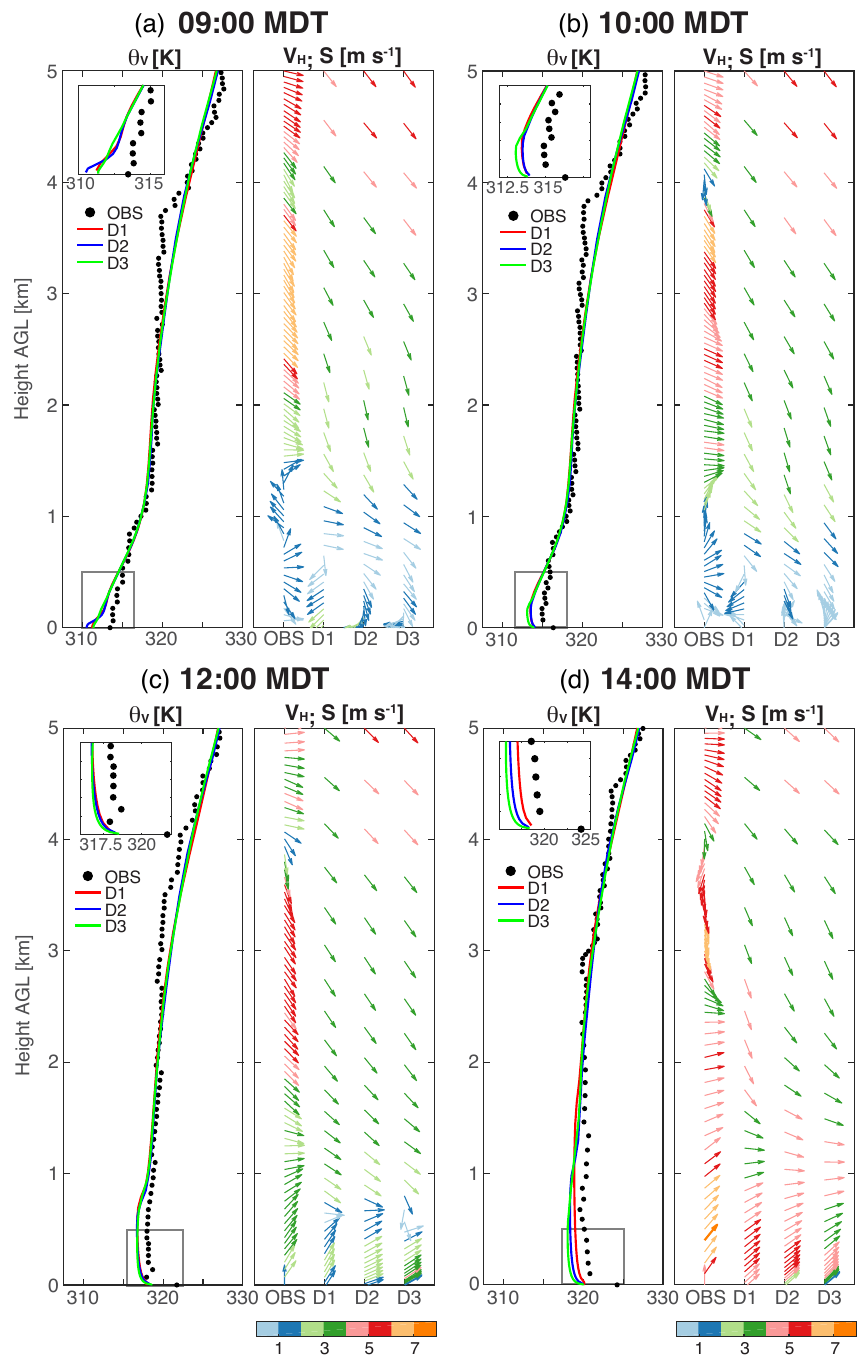
Figure 3. Vertical profile comparison of portable rawinsonde sounding and model sounding at nearest grid point to sounding launch site (red triangle in Figure 1c), at ( a ) 09:00, ( b ) 10:00, ( c ) 12:00, and ( d ) 14:00 MDT 10 September 2018, for all three model domains. In each panel, left sub-panel depicts virtual potential temperature, and right sub-panel depicts wind vectors (color scale for wind speed included at bottom of figure). In order to focus on the planetary boundary layer (PBL), only the lowest 5 km of the atmosphere is displayed. Inset panels in upper-left corner of each virtual potential temperature panel depict the lowest 500 m of the model